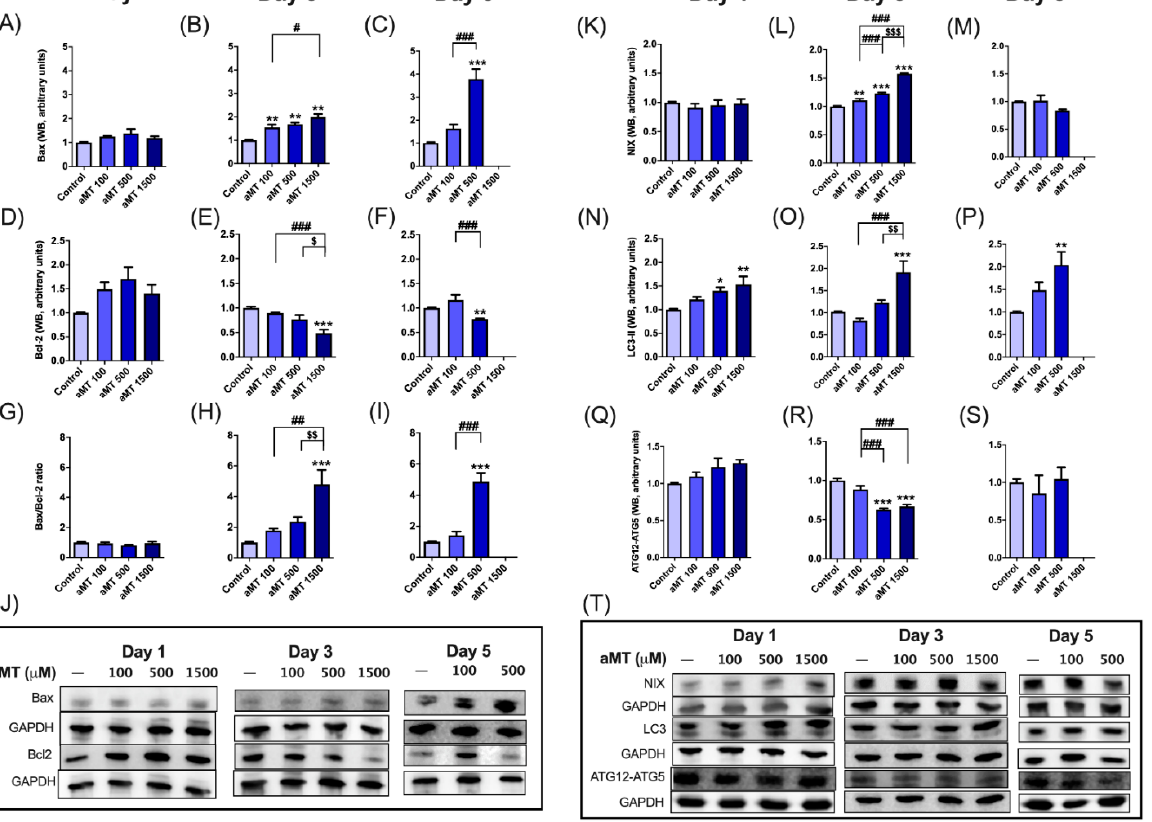
Figure 8. Increases in apoptosis and autophagy caused by melatonin in Cal-27 cells. Western blot analysis of Bax ( A – C , J ), Bcl-2 ( D – F , J ), Bax/Bcl-2 ratio ( G – I ), NIX ( K – M , T ), LC3 ( N – P , T ), and ATG12-ATG5 ( Q – T ). Data for aMT 1500 group are not shown at day 5 because most cells died. n = 6 per group. Data are presented as mean ± SEM. * p < 0.05, ** p < 0.01, *** p < 0.001 vs. control; # p < 0.05, ## p <0.01, ### p < 0.001 vs. aMT 100 µM group; $ p < 0.05, $$ p < 0.01, $$$ p < 0.001 vs. aMT 500 µM group.